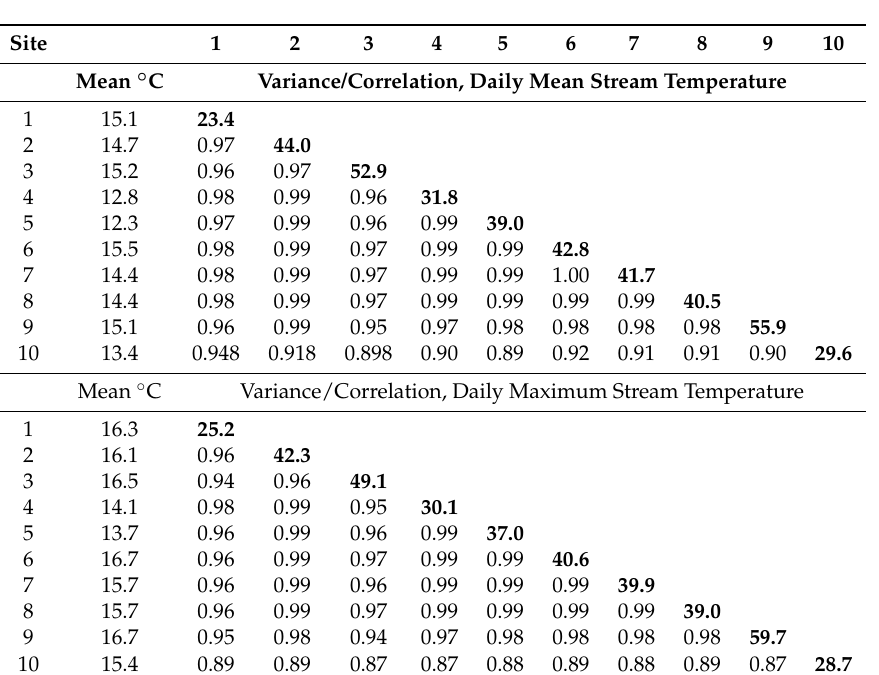
Figure 3. Daily mean ( top ) and maximum ( bottom ) stream temperature ( ◦ C) at each recording site. Mean daily stream temperature and mean daily maximum stream temperature over the data collection period is represented by the dotted lines. Table 2. Matrix for comparison of mean daily, daily maximum, and variance of stream temperature (bold), and correlations between